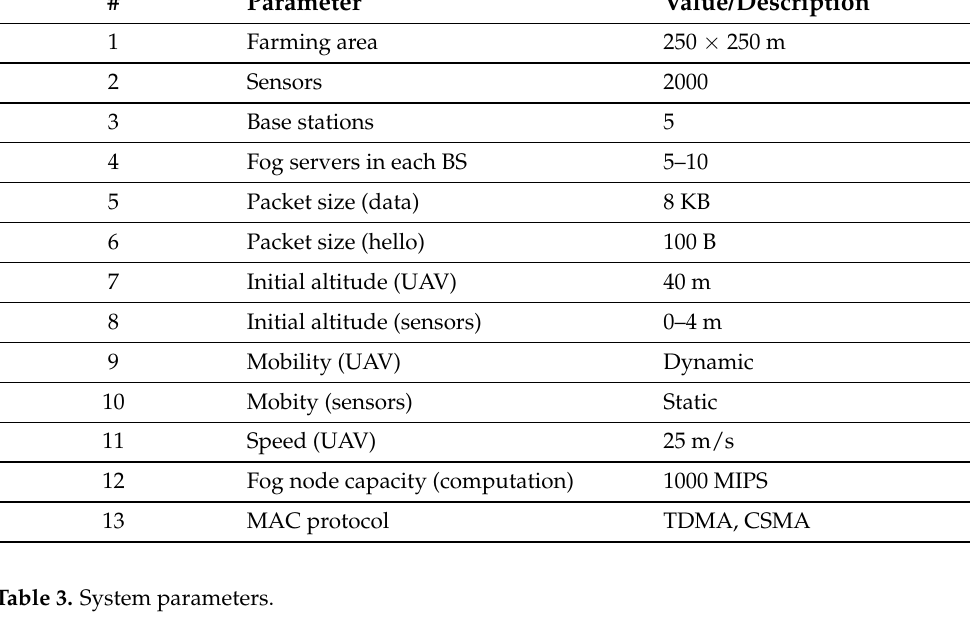
Table 2. Simulation parameters.